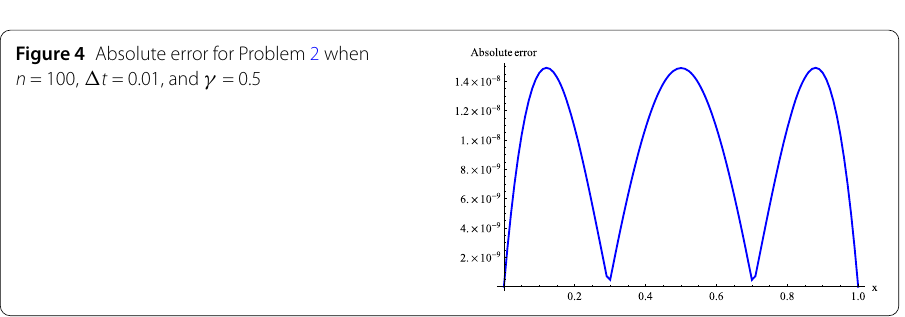
Figure 4 Absolute error for Problem 2 when n = 100, (cid:12) t = 0.01, and γ = 0.5